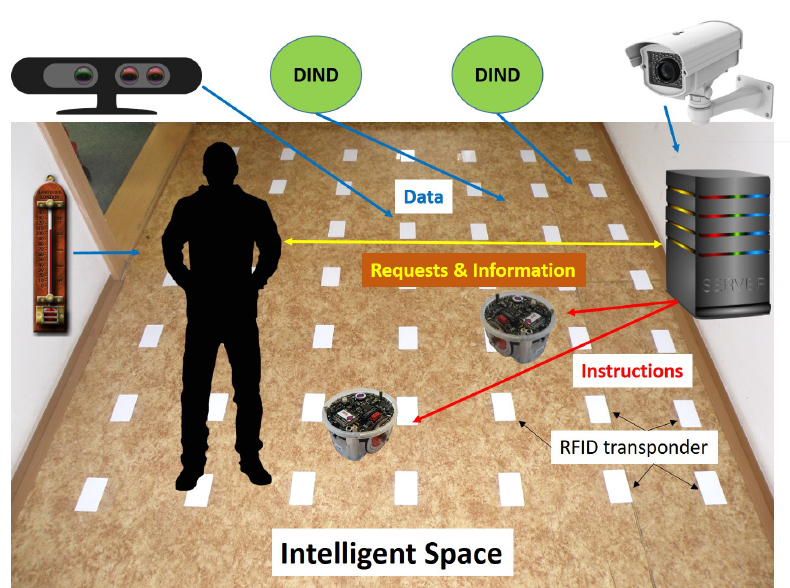
Figure 2. A schematic example of an intelligent space with depicted basic data, information and instruction